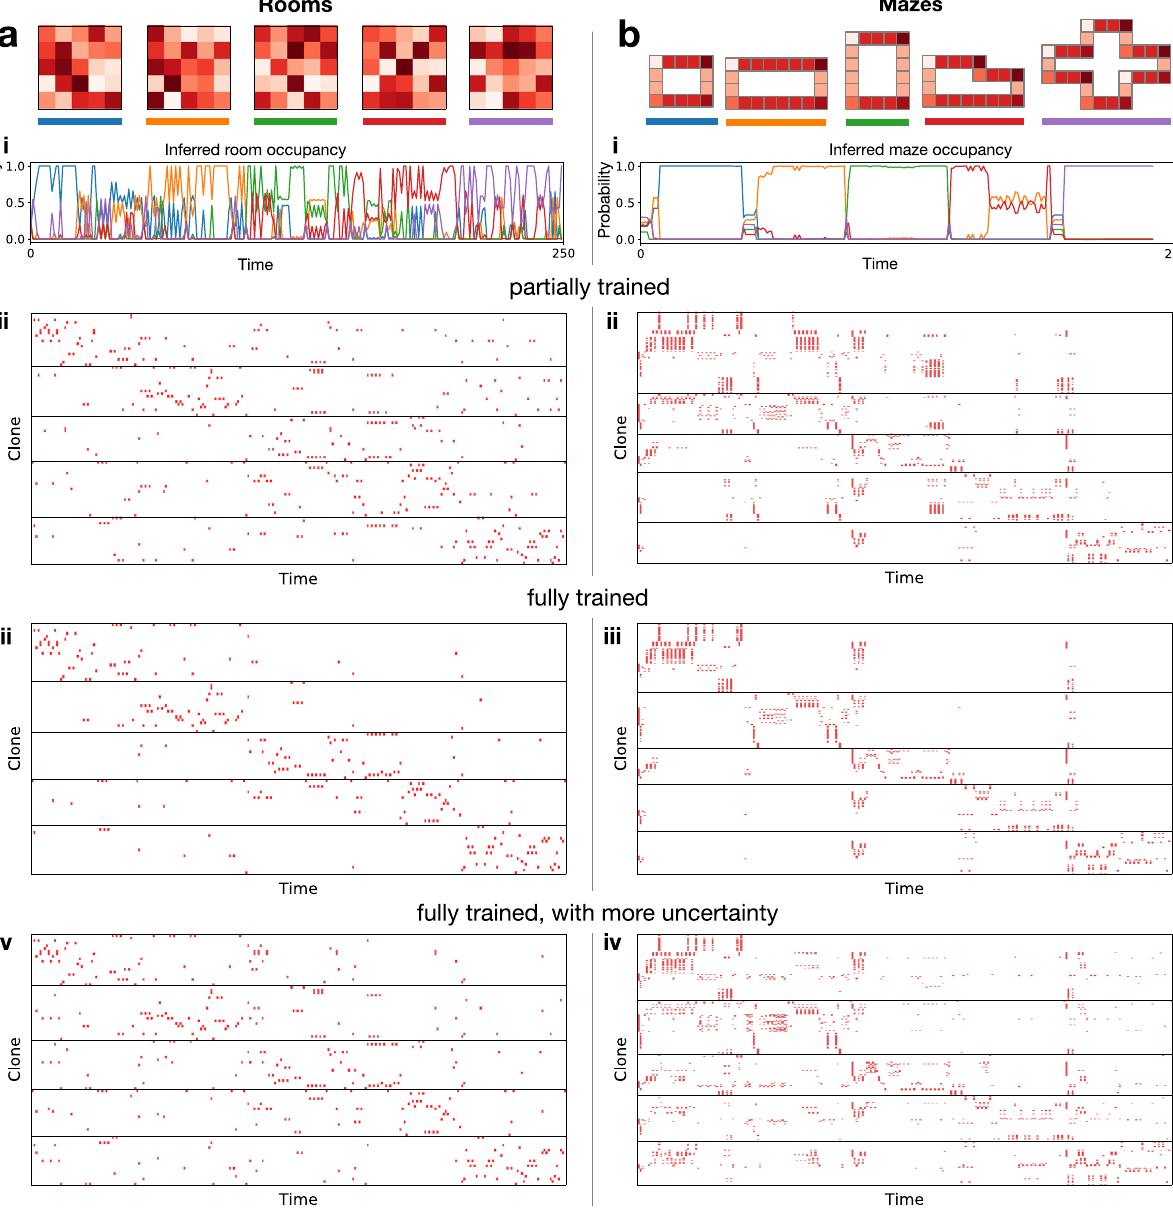
Fig. 6 Remapping. Sets consisting of fi ve different rooms ( a ) and mazes ( b ) are used to study activity remapping. In set a , the fi ve rooms share 25 different observations, arranged randomly, and in set b , the fi ve mazes share six observations arranged in geometrical shapes. Different shades of red represent different observations. Row (i): inferred probability ( Y -axis) of being in a room/maze as a function of time ( X -axis). Rows (ii) – (iv) Clone activity traces for a random walk of 50 steps each in rooms (mazes) 1 – 5 under different conditions (partially trained, fully trained, and more uncertainty). All traces are based on the same random walk and use the same clone ordering. Activity traces corresponds to global remapping in a partially trained CSCG, and partial remapping in a partially trained CSCG. Adding more uncertainty to a fully trained CSCG produces activity traces that correspond to rate